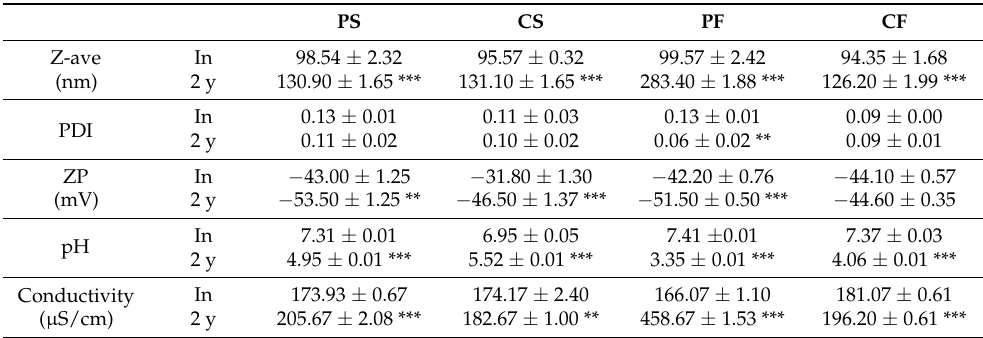
Physicochemical parameters for non-PEGylated nanoemulsions, with soybean oil (PS—placebo and CS—curcumin-loaded) and fish oil (PF—placebo and CF—curcumin-loaded) mea- sured initially (In) and after two years of storage at room temperature (2